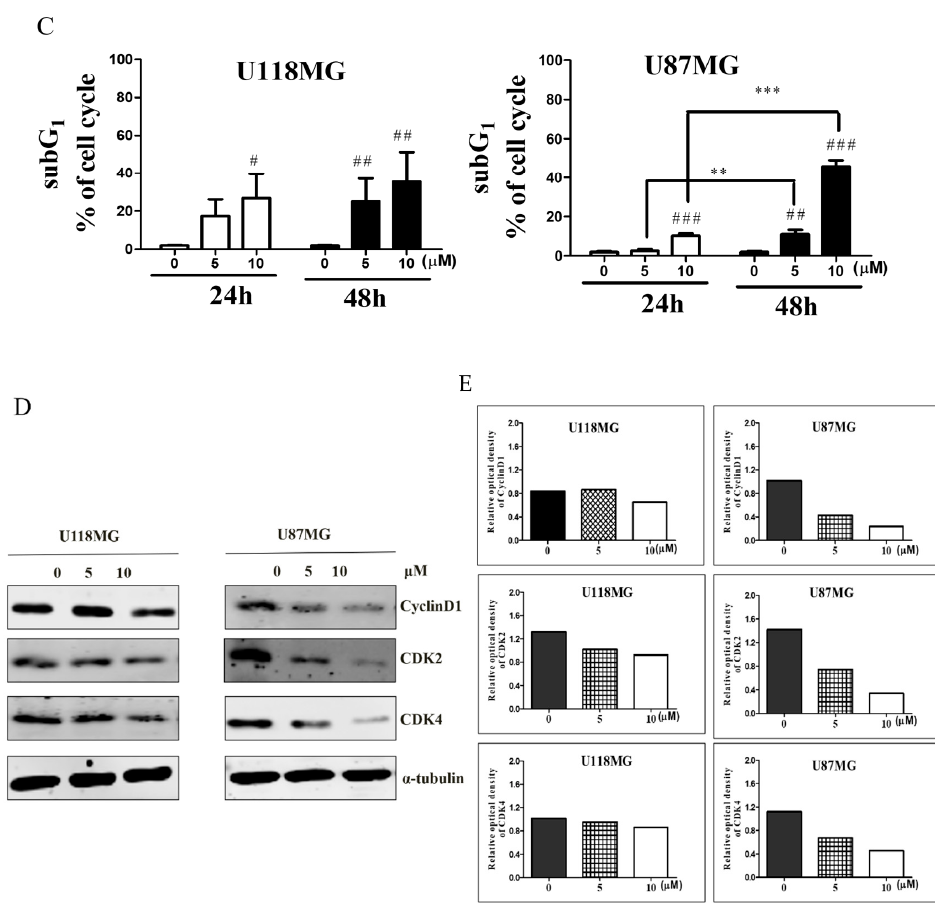
Figure 3. CC12 inhibited cell proliferation. ( A ) Western blot results showed the decrease of the proliferation marker Ki-67 after CC12 treatment. Flow cytometric analysis indicated that CC12 treatment increased the apoptosis by ( B ) the presence of hypodiploid peak and ( C ) the significant increase of the proportions of sub-G1 phase cells. ( D ) The protein expressions of G1 phase drivers decreased in U87MG cells; however, there were no changes in U118MG cells. ( E ) The quantification analysis of the western blot results. # and ## indicates significant difference compared with the control group, p < 0.05 and < 0.01, respectively; * and *** indicates the significant difference between 24 h and 48 h treatments within the same concentration groups, p < 0.05 and < 0.01, respectively.